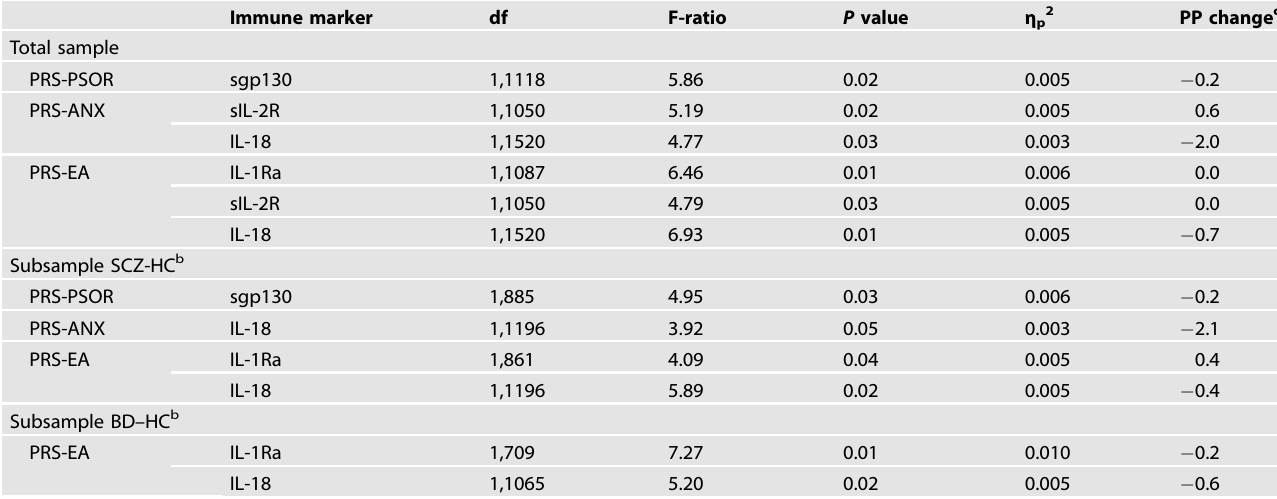
Table 3. Main effects of polygenic risk scores on immune markers a